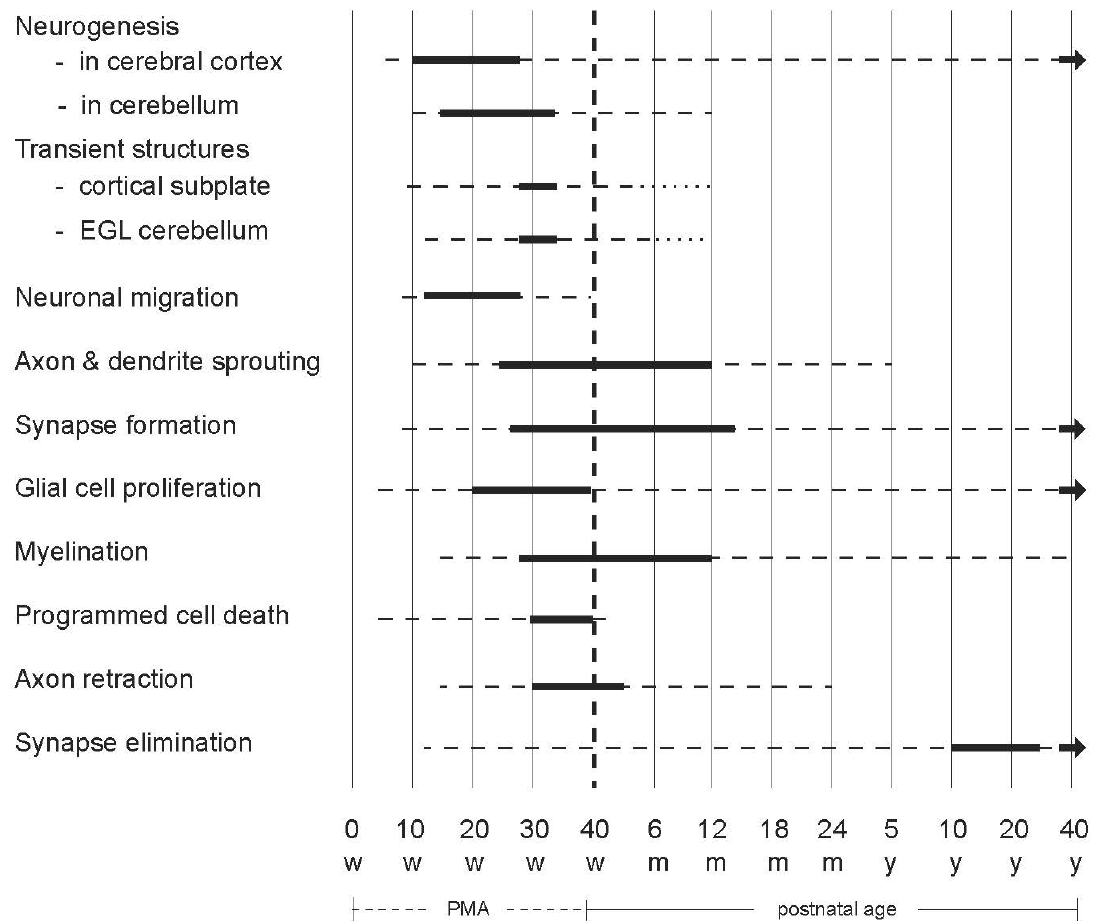
Figure 1. Schematic overview of the developmental processes occurring in the human brain (based on [31]). The bold lines indicate that the processes mentioned on the left side are very active, the broken lines denote that the processes continue but less abundantly. EGL = external granular layer; m = months; PMA = postmenstrual age; w = weeks; y = years. Figure reproduced with permission from ‘Early Detection and Early Intervention in Developmental Motor Disorders—from neuroscience to participation’ by Mijna Hadders-Algra (ed.) published by Mac Keith Press in its Clinics in Developmental Medicine Series, ISBN number 978 ‐ 1 ‐ 911612 ‐ 43 ‐ 8.